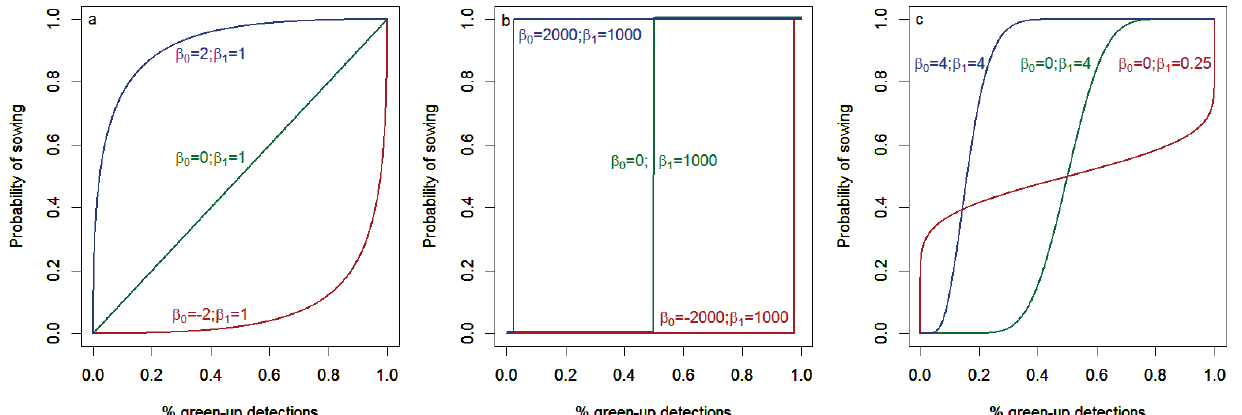
Figure 2. Potential functional forms between the percentage of pixels for which a vegetation onset has been detected and the probability of a successful sowing. A high diversity of functional forms can be obtained with only two parameters. i.e. , β 0 and β 1 in Equation (2). Linear, strictly positive and strictly negatives second derivatives with β 1 = 1 ( a ); threshold with β 1 →∞ ( b ); and change in concavity with β 1 ≠ 1 ( c ). Only positive values of β 1 are